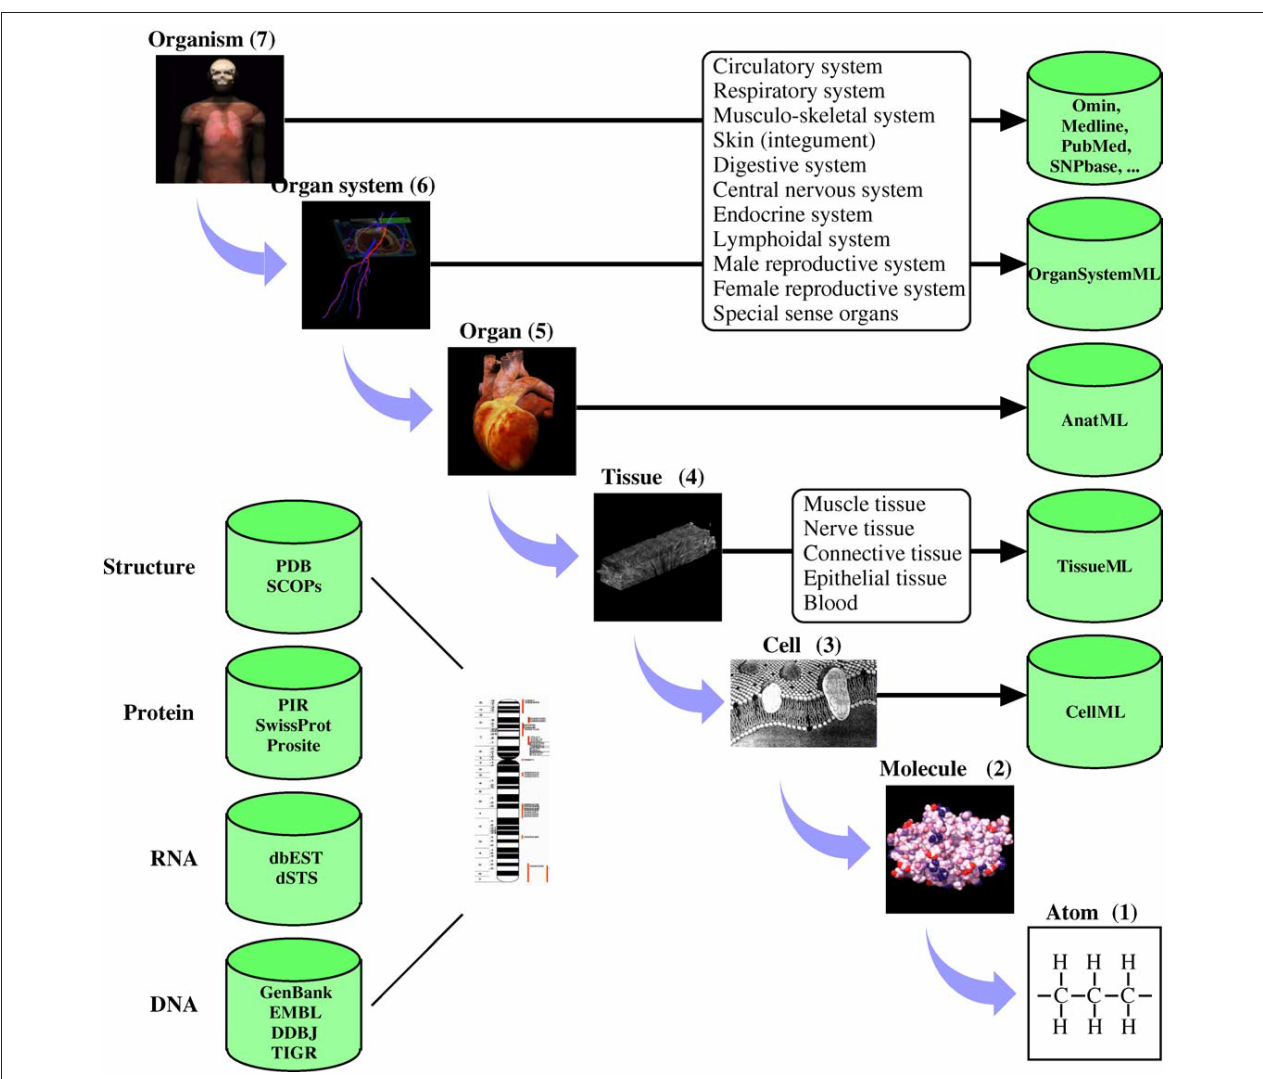
FIGURE 1 | Physiological systems, processes, and corresponding spatial scales encompassed by the Human Physiome Project. The databases hold physiologically relevant data and model information encoded in markup languages such as CellML (see www.cellml.org) and FieldML. The markup languages ensure that models are encoded in a consistent form and allows simulation packages to import the models in a standard format. Reproduced with permission from Hunter